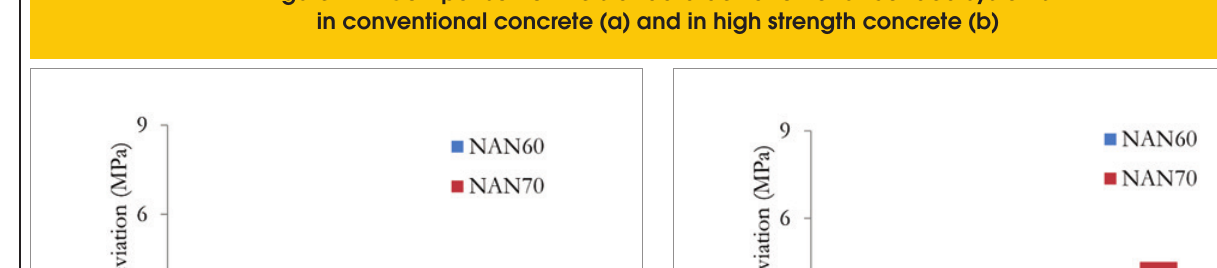
Figure 14 – Comparison of the standard deviation of unbonded systems in conventional concrete (a) and in high strength concrete (b)